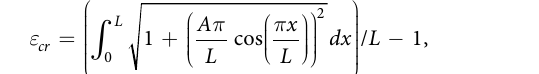
denoting the strain to fully extend the curved beam with sin wave, as marked by the dashed line in Fig. 4(a–c). Figure 4(b) shows that the relation of horizontal strain and vertical strain increases linearly at a low strain, but after a vertical critical strain, it approaches to a plateau which is the horizontal critical strain. It can be noticed that the vertical critical strain and horizontal critical strain are equal, which can be estimated as Eqn. 6. The calculated incremental Poisson’s ratios show negative values as − 0.856 and − 0.925 for the specimen with A / L = 0.2 and 0.6 respectively in Fig. 4(c). With the deformation mechanisms switching from bending to stretching at the critical strain, the Poisson’s ratio increase dramatically from negative to almost zero. The deformed configurations of the representative unit cell based on the theoretical prediction show very good accordance with the FEA results under different strain levels as shown in Fig. 4(d). It can be noted that the negative Poisson effect originates mainly from the dilatation of the lattice-shaped unit cell. Here, the beams deform from curved to straight in both directions which indicate a full expansion along the horizontal direction during vertical stretching. Therefore, our analytical model explains the reason for the auxetic behavior of this lattice structure and demonstrates a clear transition of deformation mode from bending-dominated to stretching-dominated behaviors in the uniaxial stretching. Having demonstrated that the lattice metamaterials exhibit auxetic behavior under uniaxial tension at specific strain ranges, we now systematically investigate the effects of geometry parameters on the evolution of Poisson’s ratios, v . Because the Poisson’s ratio is highly strain-dependent, we select the values at very small strains ( ≤ 0.02) for each specimen. In Fig. 5(a), we report the evolution of v as a function of A / L for different values of w / L (0.01– 0.20), while t / L is kept constant of 0.1. First, the results indicate that, as A / L increases, v initially drops, reaches a